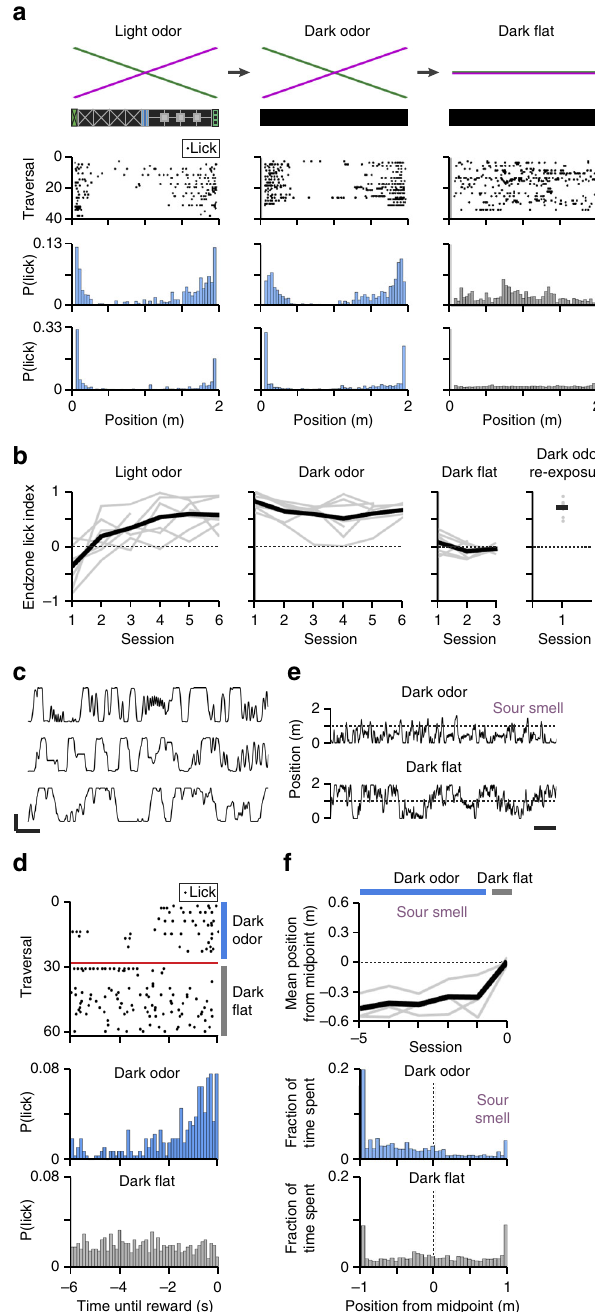
Fig. 3 Mice can perform odor-guided behaviors in virtual space. a Three environmental sensory conditions (row 1). Single-session licking raster plots for the same mouse in each condition during separate sessions (row 2). Each dot represents a lick. Each row includes all of the time elapsed since the previous reward. To exclude reward consumption, licks at positions at and beyond the reward sites are not plotted. Histograms of lick position for data shown in row 2 (row 3). Histograms of lick position pooled over all 7 mice on the fi nal session in each condition (row 4). b Training curves for all seven mice, measured as endzone index across days. Gaps in the curves occur where the mouse did not lick, did not achieve rewards, or had completed its training in the present condition. After sequential training in the light odor (left), dark odor (middle left), and dark fl at (middle right) conditions, mice were able to perform well upon re-exposure to the dark odor condition (right). c Example position traces from three different mice on the fi nal training session in the dark odor condition. Scale bar = (1 m, 1 min). d Temporal licking raster plot for one mouse during its fi rst transition from the dark odor condition to the dark fl at condition in the same session (top). Histograms of lick position during the transition, pooled over all seven mice (bottom). e , f In this experiment, methyl valerate was replaced with sour-smelling oxidized methyl valerate. e Example position trace for one mouse in its fi nal session in the dark odor condition (top). The same mouse in the fi rst session in the dark fl at condition (bottom). Scale bar = (1 m, 1 min). The mouse avoided the sour smell in the dark odor condition. f Mean track positions for three mice for fi ve sequential sessions in the dark odor condition and one session in the dark fl at condition (top). Histograms of track position pooled from all three mice on sessions – 1 (middle) and 0 (bottom). Peaks occur at the endzones because mice were more likely to get “ stuck ” there, i.e., half of the possible view angles point into the wall rather than along the